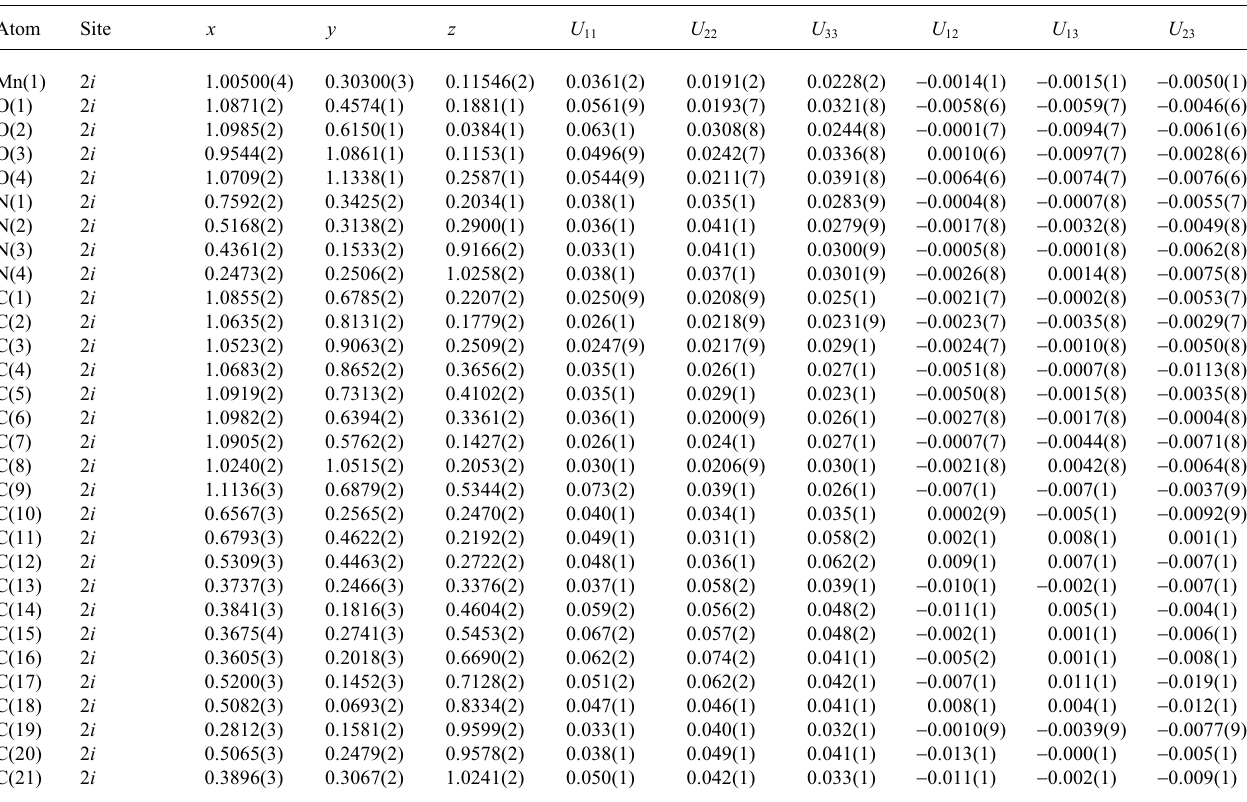
Table 3. Atomic coordinates and displacement parameters (in Å 2